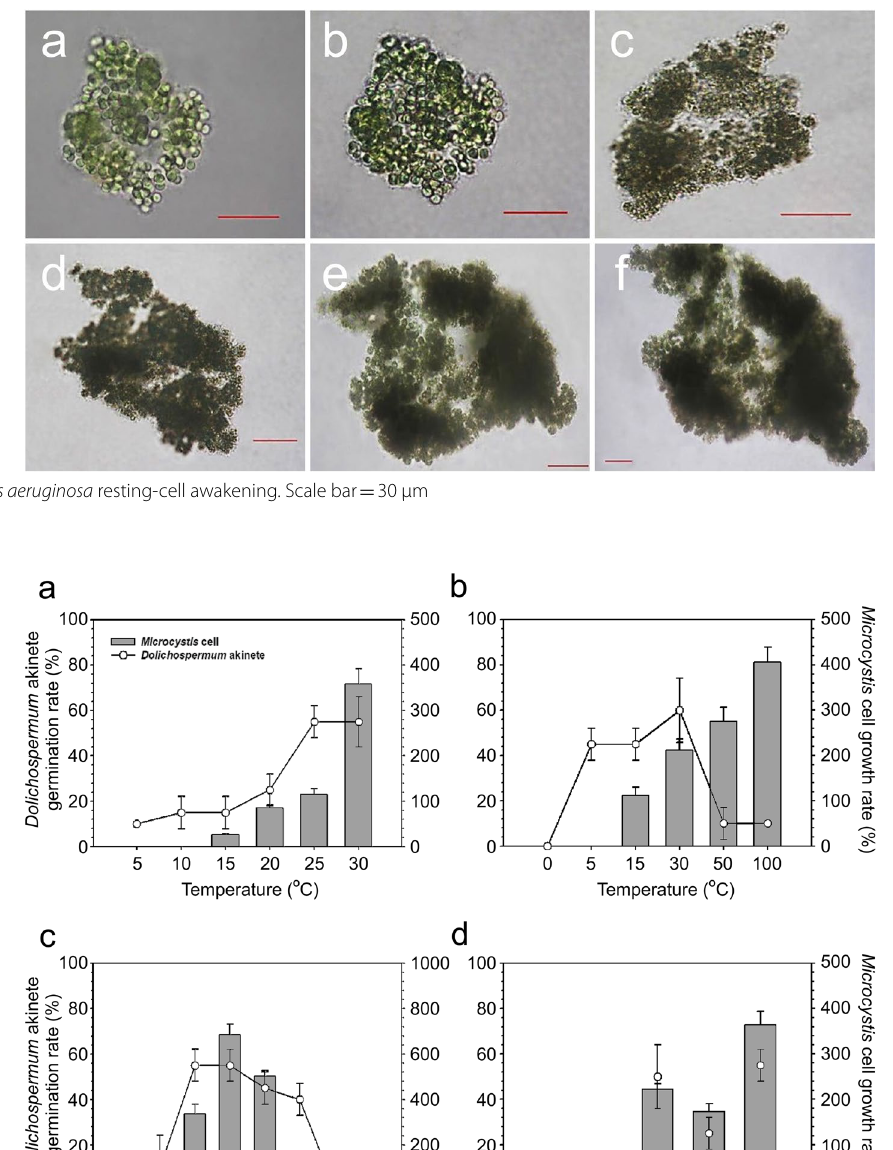
Fig. 7 Germination and growth rates of akinetes and resting cells under various